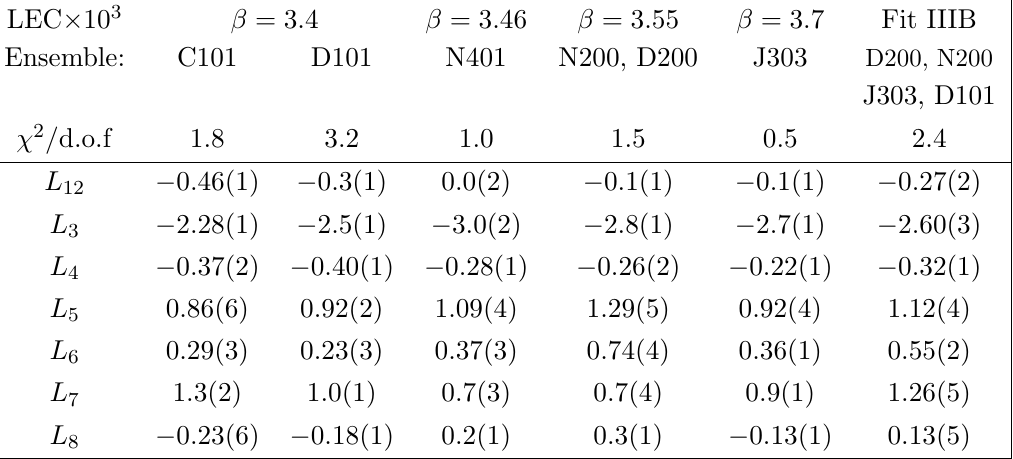
Table 7 . Values of the LECs obtained in the (cid:12)ts Tr M = C with the scale setting B